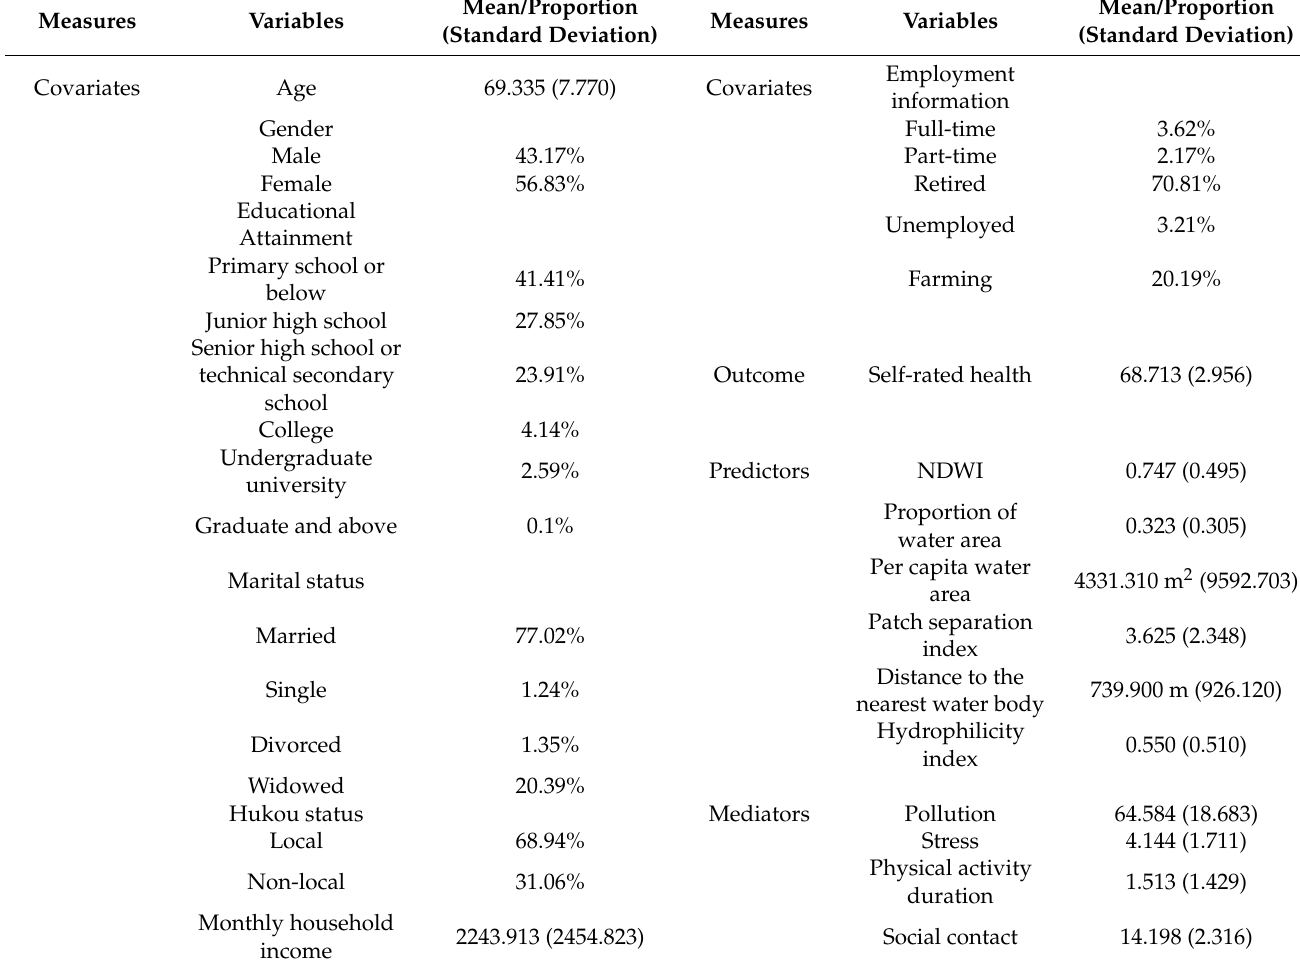
Table 2. Summary statistics for all